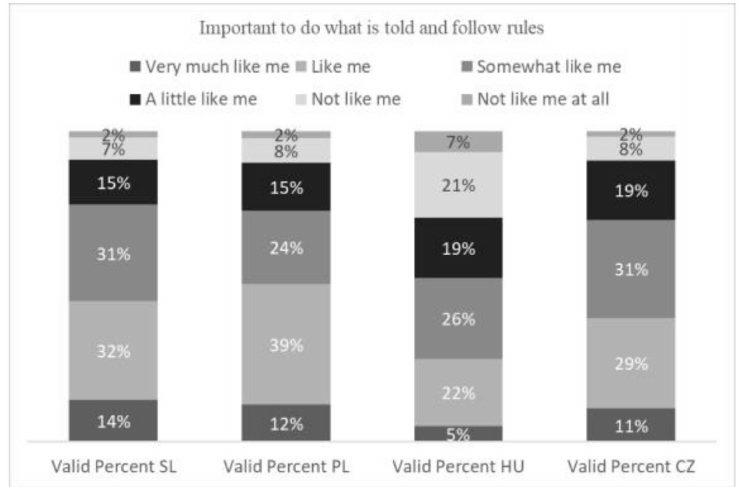
Figure 8. Responses for the importance of living in safe and secure surroundings.